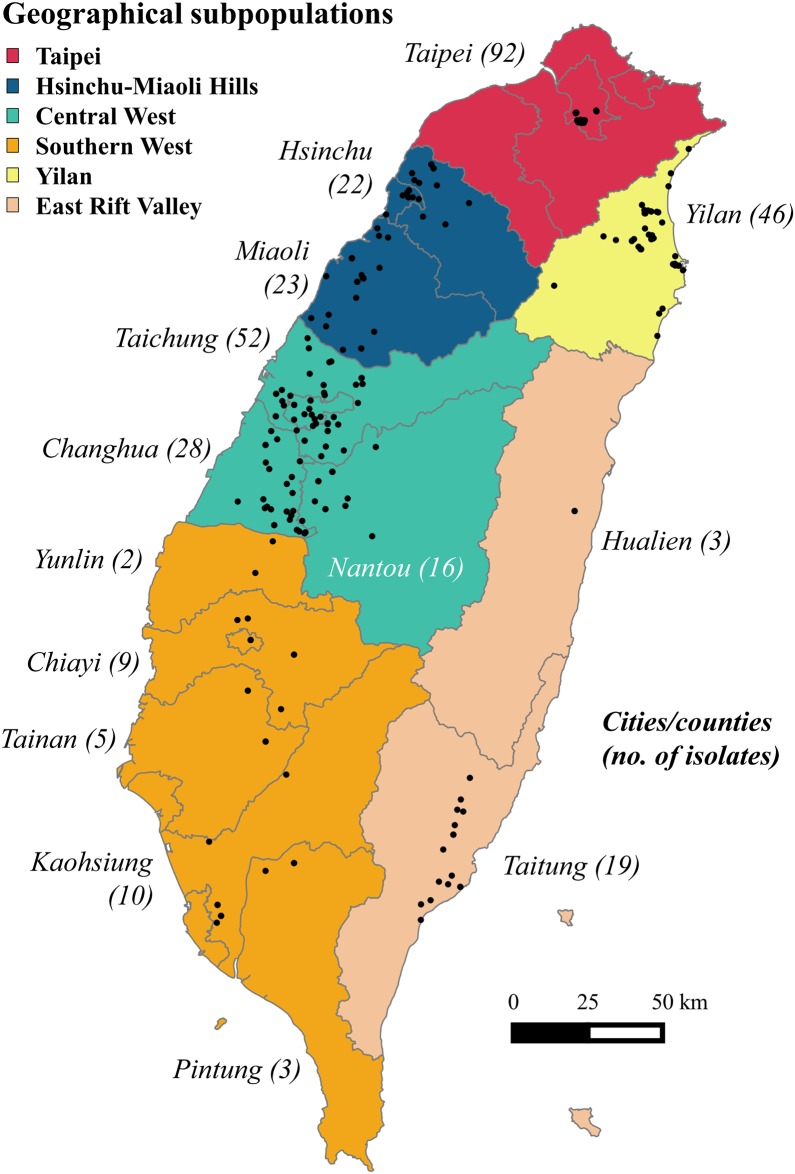
A total of 3291 isolates of Phellinus noxius were sampled from 14 cities/counties in Taiwan.The cities/counties and the numbers of P. noxius isolates from the areas are in italic. Different colors indicate the extent of the six geographical subpopulations: Taipei (TP), Hsinchu-Miaoli Hills (HM, including Hsinchu and Miaoli), Central West (CW, including Taichung, Changhua, and Nantou), Southern West (SW, including Yulin, Chiayi, Tainan, Kaohsiung, and Pintung), Yilan (YL), and East Rift Valley (EV, including Hualien and Taitung).